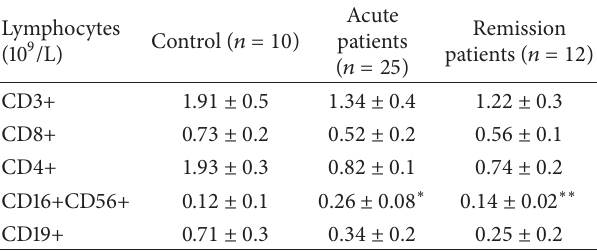
Table 2: Changes in the peripheral lymphocyte population in juvenal